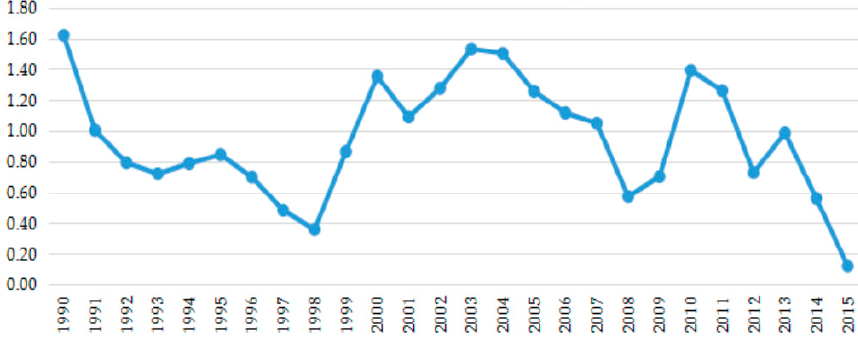
Figure 1. Elasticity coefficient of electricity consumption in China (1990–2015).